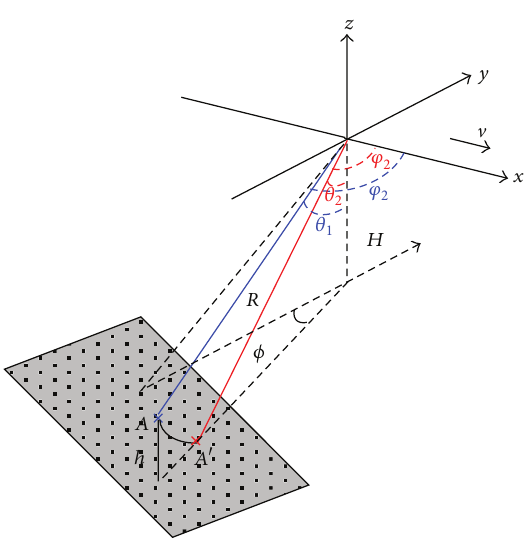
Figure 4: The geometry of terrain height